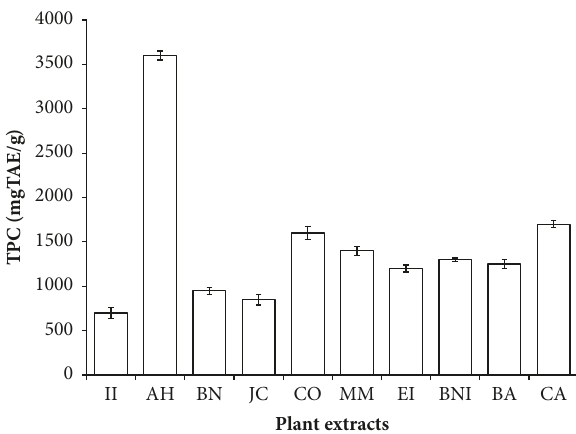
Figure 2: The total flavonoid content (TFC) of selected plants used in the management of oral and skin infections in southeast Nigeria. II, Ipomoea involucrata ; AH, Acalypha hispida ; BN, Breynia nivosa ; JC, Jatropha curcas ; CO, Chromolaena odorata ; MM, Macrolobium macrophyllum ; EI, Eleusine indica ; BNI, Baphia nitida ; BA, Burkea africana ; CA, Cassia alata ; QE, Quercetin equivalent.